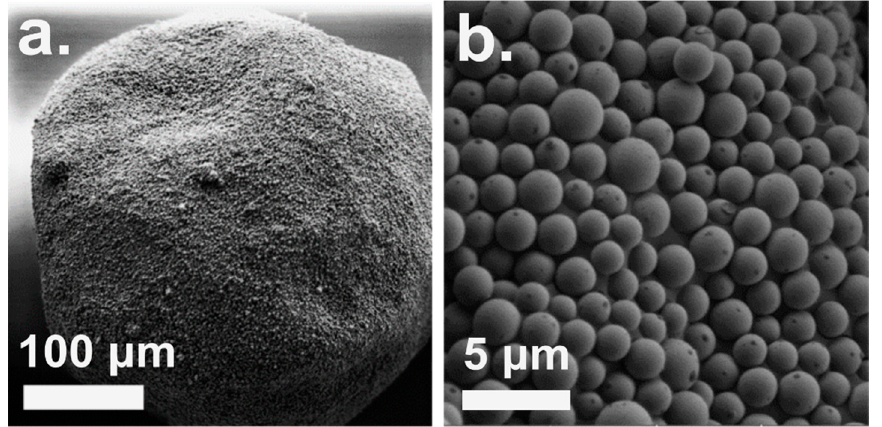
Figure 3. Plan view SEM micrographs of PC/PMSQ microsphere formed via inverse solvent displacement method. ( a ) Overview of a characteristic PC/PMSQ microsphere and ( b ) PMSQ particles embedded on the surface of a PC microsphere.